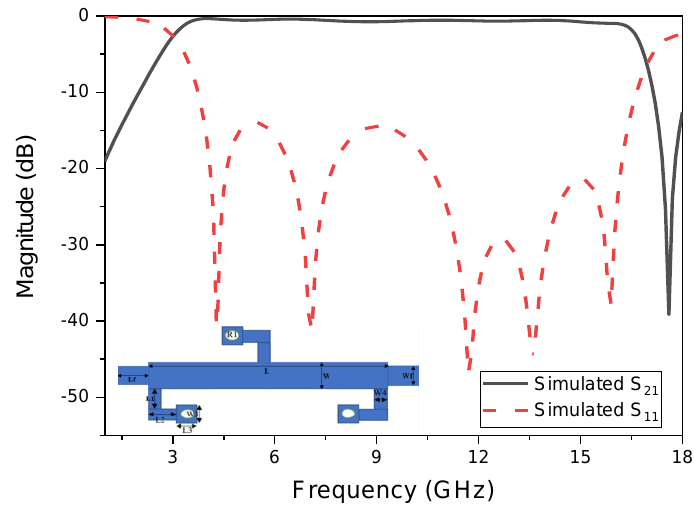
Figure 5. Simulated frequency plots of the SUWB-BPF with proposed rectangular